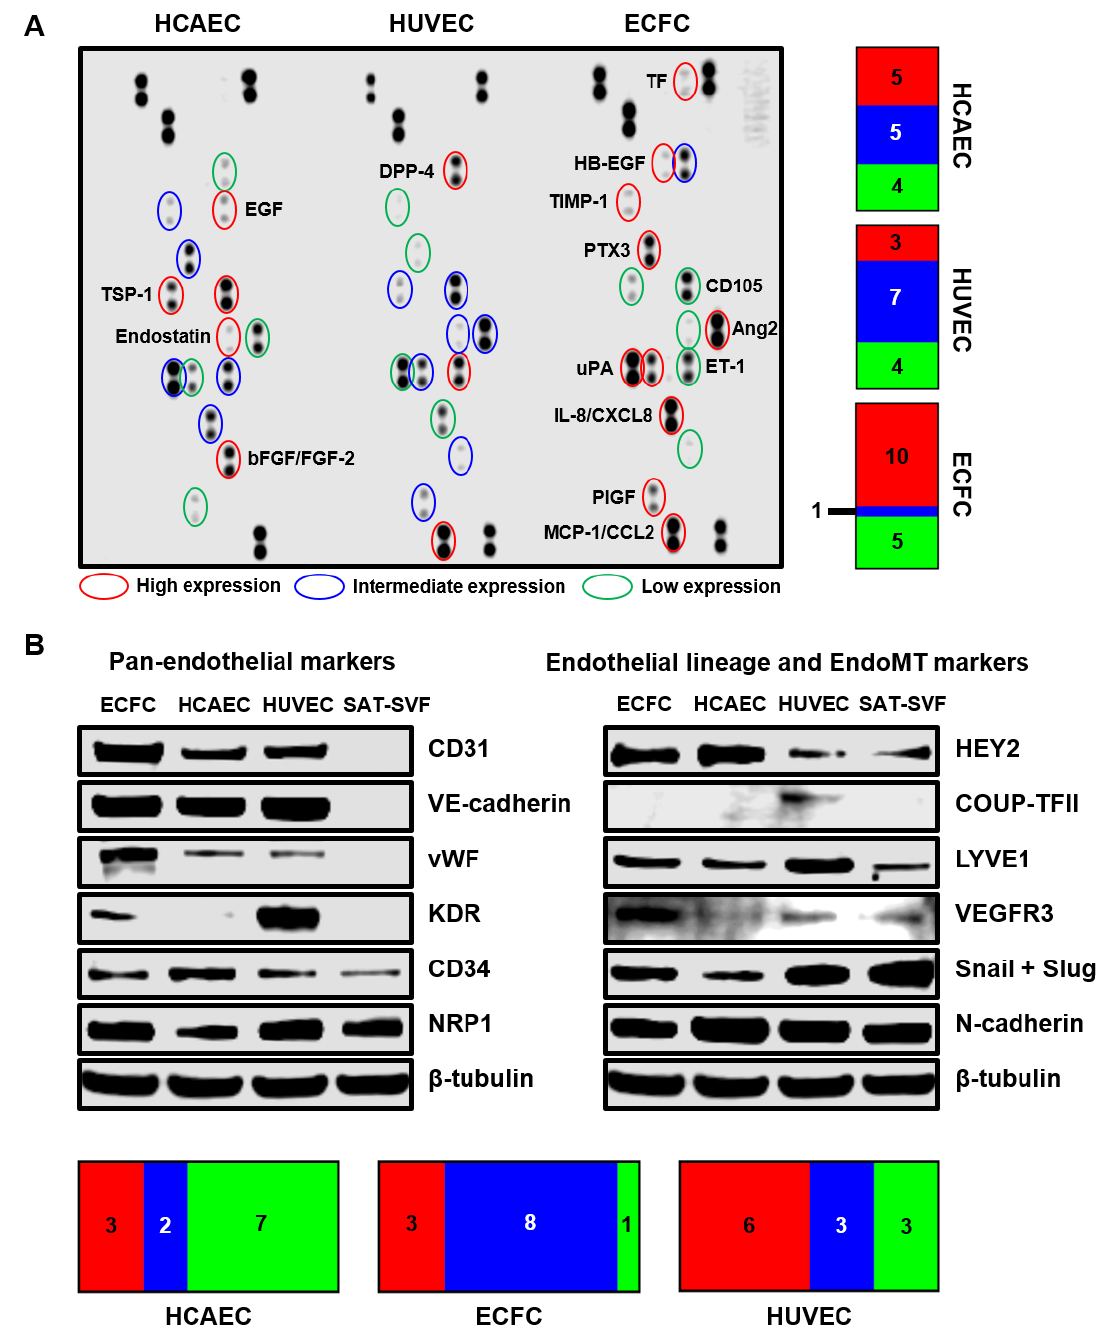
Figure 9. Proteomic profiling for ECFC, HCAEC and HUVEC. ( A ) Dot blot profiling for 55 angiogenesis-related proteins confirms high similarity between ECFC and mature vascular EC yet also indicates minor differences between these cell lines and generally validating RNA-seq results. Count to the right represents a quantitation of measured angiogenesis-related proteins in terms of their relative expression in HCAEC, HUVEC, and ECFC; ( B ) Western blotting for endothelial phenotype-related markers verifies endothelial identity of PBMC-derived ECFC and demonstrates an intermediate phenotype of PBMC-derived ECFC as compared to HCAEC and HUVEC in terms of HEY2, LYVE1, VEGFR3, Snail and Slug expression. β -tubulin was probed as a loading control. Count to the bottom represents a quantitation of measured endothelial phenotype-related markers in terms of their relative expression in HCAEC, HUVEC, and ECFC.